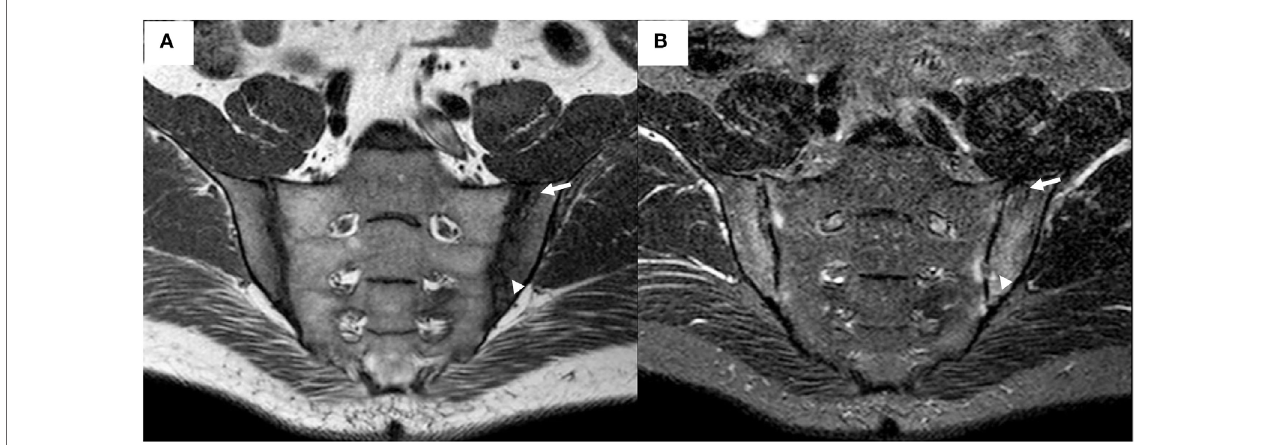
FiGURe 2 | Magnetic resonance imaging (MRI) of the sacroiliac joints (same patient as depicted in Figure 1 ) demonstrates bilateral irregularity of the joint margins, and subchondral bone marrow edema appearing as a hypointense signal on T1-weighted (T1w) sequence (A) and as a hyperintense signal on short tau inversion recovery (STIR) sequence (b) , fulfilling the Assessment of SpondyloArthritis Society criteria for positive MRI for sacroiliitis. An area of subchondral sclerosis with hypointense signal on both sequences (arrow), and an active erosion with hypointense signal on T1w sequence and hyperintense on STIR sequence (arrowhead), are visible in the left